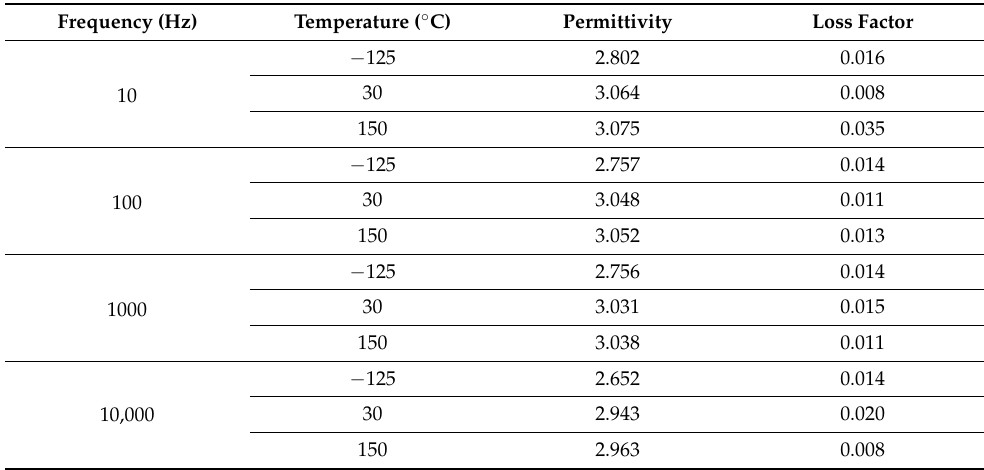
Table 9. Permittivity and loss factor of cured resin at 10, 100, 1000 and 10,000 Hz, and − 125, 30 and 150 ◦ C in DGEBA:B10 =